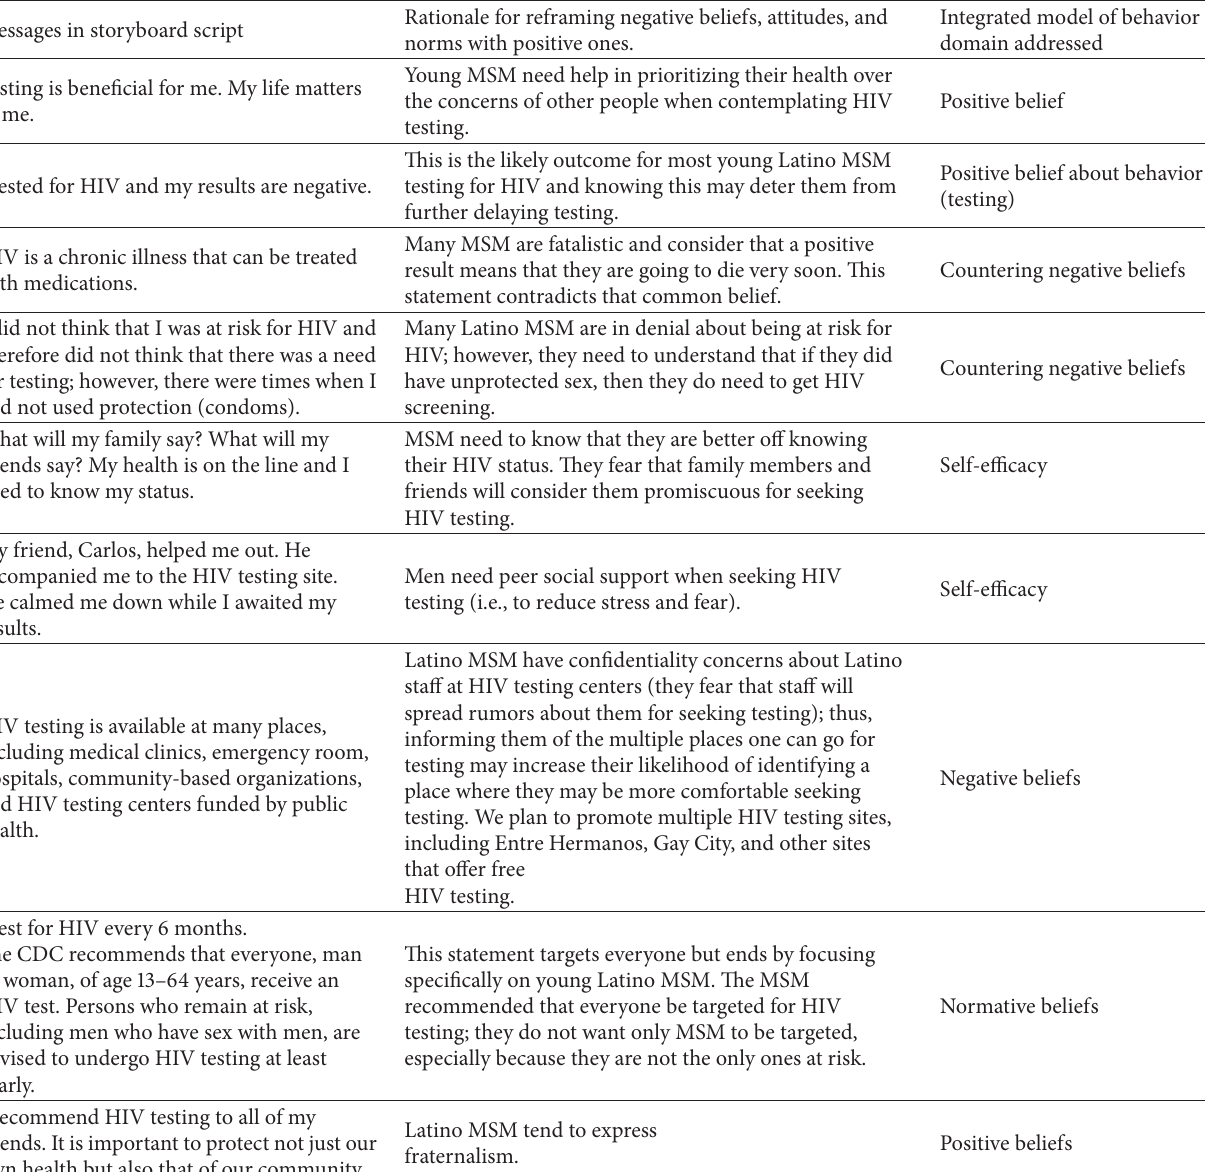
Table 1: Reframing negative HIV testing attitudes, beliefs, and norms with positive ones. Messages in storyboard